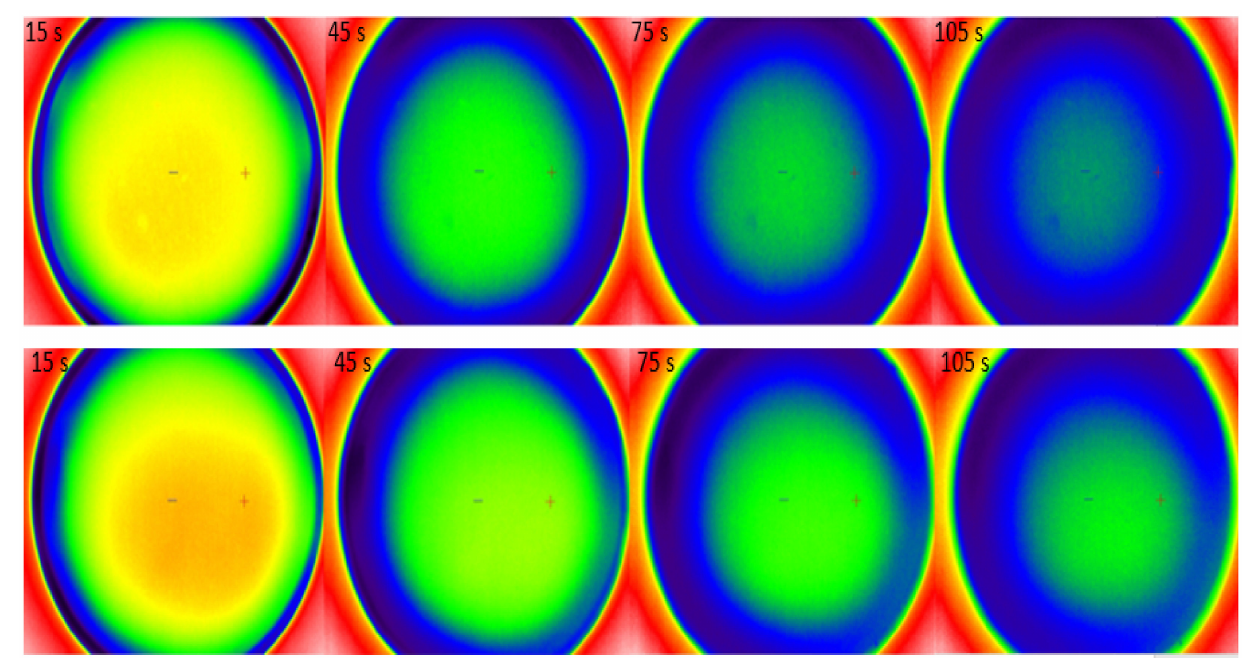
Figure 1. Thermograms of mortadella samples thermograms at 15, 45, 75, and 105 s with the thermal imaging camera. Upper row: Uncontaminated sample (control). Lower row: Sample contaminated on the surface with a B. subtilis ATCC 6633 suspension with 6.8 × 10 6 CFU/g contamination